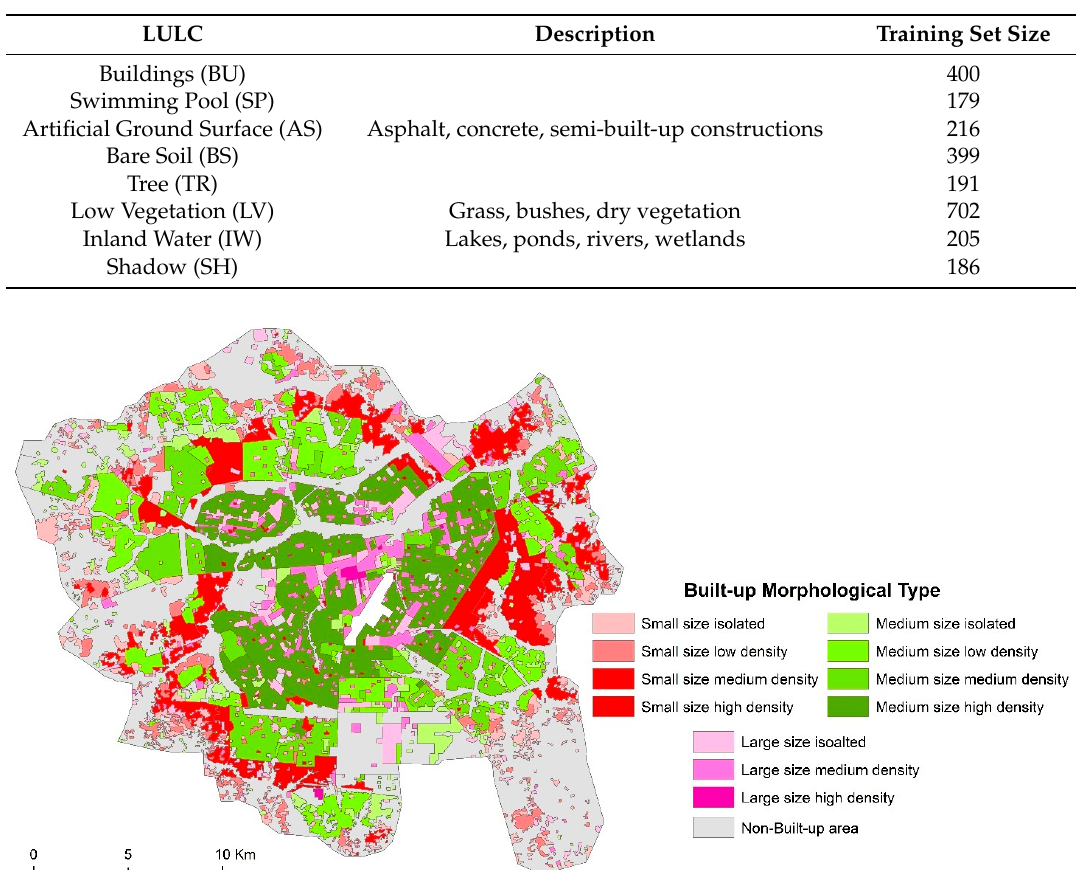
Figure 4. Morphological delineation of Ouagadougou based on built-up size and density categories .